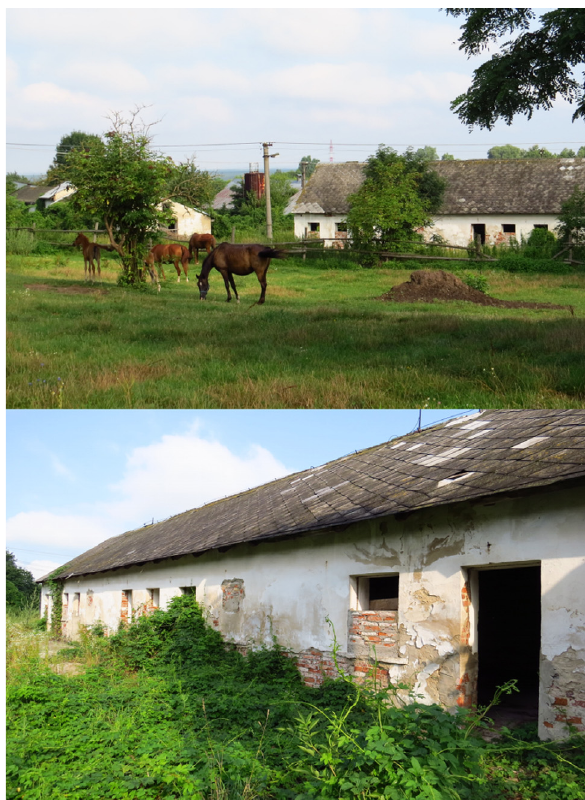
Figure 2. A barn on the farm in Pernek, Slovakia where the female Phlebotomus mascittii specimen was collected.